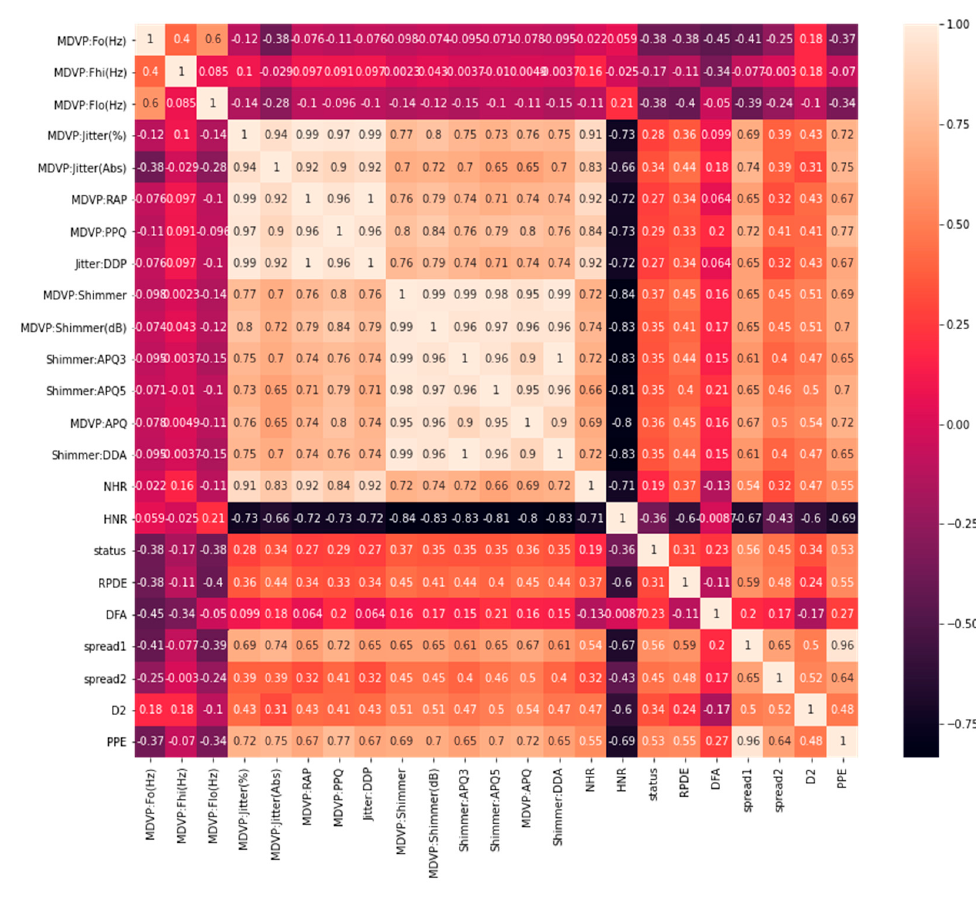
Figure 1. Correlation heatmaps.